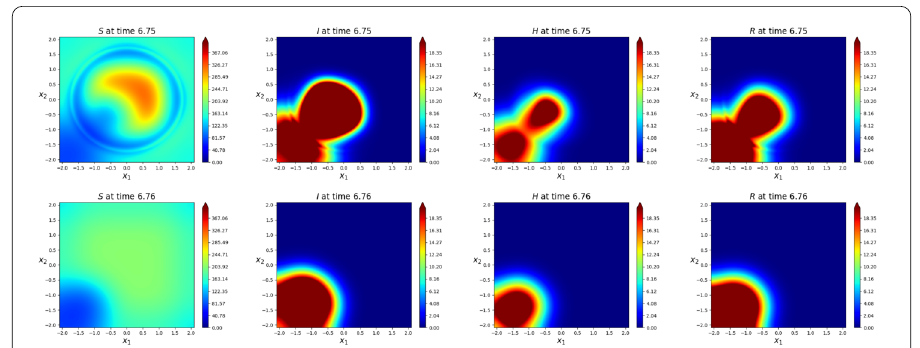
Figure 17 Solution to (8) at time, above, t = 6.75 and, below, t = 6.76, roughly corresponding to 6 p.m. of the 4 th day. Recall that the vector field (15), used in the integration above, is 1 day periodic. Above, the combined effect of 6 days of commuting clearly results in a higher level of infection